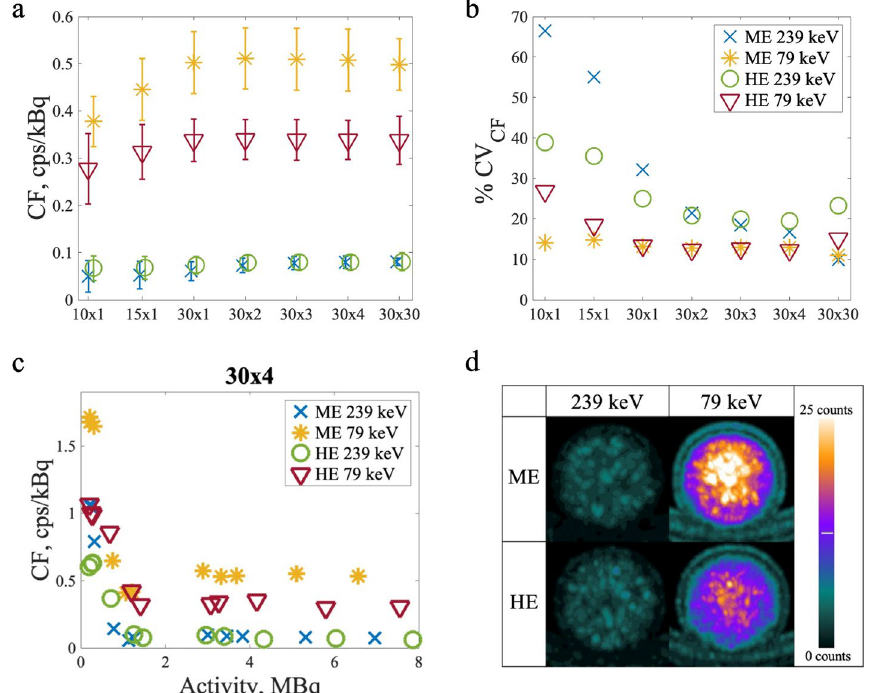
Fig. 3 Results for the CFs for the reconstructions with a filter applied with 212 Pb. In panel a , the CFs are plotted for different reconstructions with error bars showing the SDs of the CFs calculated at activities above 1 MBq. In panel b , the plot shows CVs of the CFs plotted for different reconstructions. The corresponding results for images without a filter can be found in the supplementary material. In panel c , the data points from which the CFs were calculated for the 30 4 reconstruction are plotted against activity for all four × image protocols with a filter applied. The sharp increase in CFs as activity decays below 1 MBq can be seen in the plot. In panel d , high activity maximum intensity projection images of the homogeneous phantom are presented for each of the imaging protocols with a 12‑mm filter and the 30 4 reconstruction. The scale is × set the same for all the images, to illustrate the different count rates, with the white set to 25 counts and the black being 0